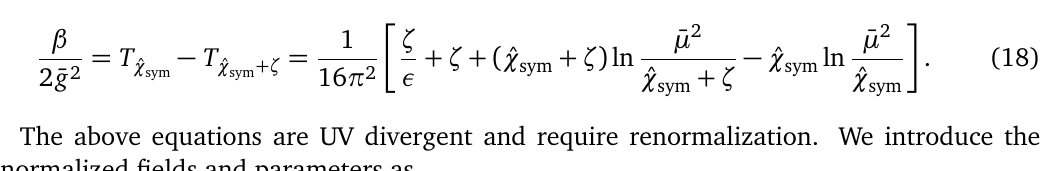
Figure 1: The classical field ˆ χ creasing (top to bottom) values of β / ¯ g 2 = 0. For positive values of this parameter (curves below the dashed one), case β r r solutions of the gap equation (22) with ˆ χ limited by the inequalities